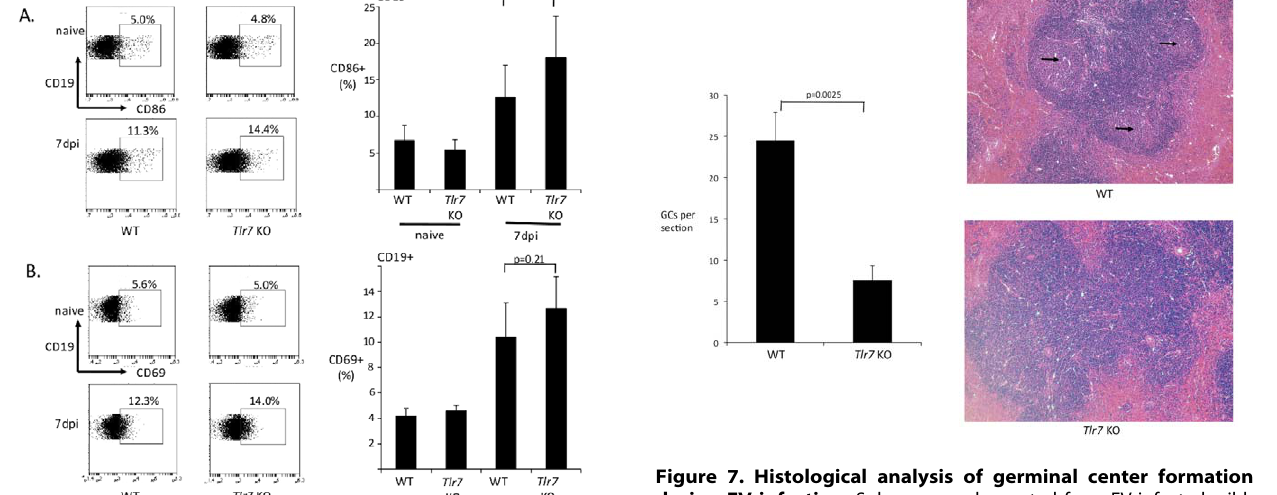
Figure 7. Histological analysis of germinal center formation during FV infection. Spleens were harvested from FV-infected wild- type (WT) or TLR7 deficient ( Tlr7 KO) mice at 14 dpi, embedded in paraffin, and sectioned onto glass slides. Sections were stained with hematoxylin and eosin. Germinal centers (GCs) were identified by their characteristic staining pattern of a paler central circular area (indicated by arrows) surrounded by a darker mantle zone and marginal zone. Five mice for each group were analyzed, and four non-consecutive sections were analyzed for each mouse.